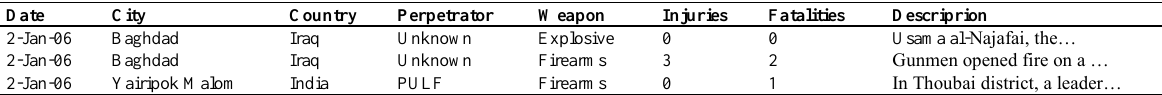
Table 2 Event data provided by Rand